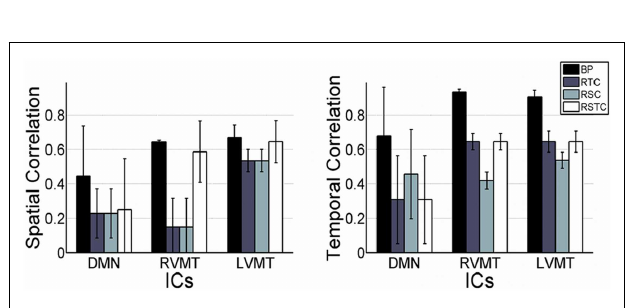
FIGURE 4 |Variability of dynamic tracking performance results due to subjects. Similar to Figure 2 , but here mean results across trials are used to compute variability across subjects, expressed as standard deviation.The subject variability is shown for each of the three networks evaluated (default mode or DMN, right visual motor or RVMT, and left visual motor or LVMT) and for each of the four ICA implementations (Back-projection or BP, temporally constrained orTC, spatially constrained or SC, spatio-temporal constrained or STC).